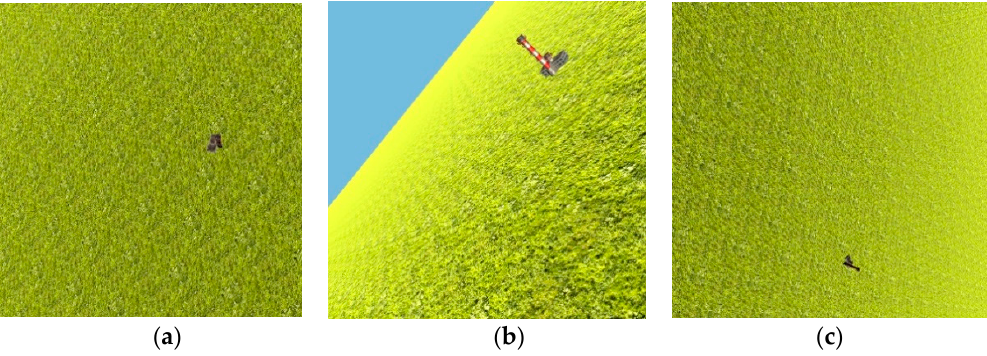
Figure 3. In total, 6000 images were produced in pixel size 2000 × 2000: 5000 for training and 1000 for validation. 3 Examples of the images can be found in ( a – c ).